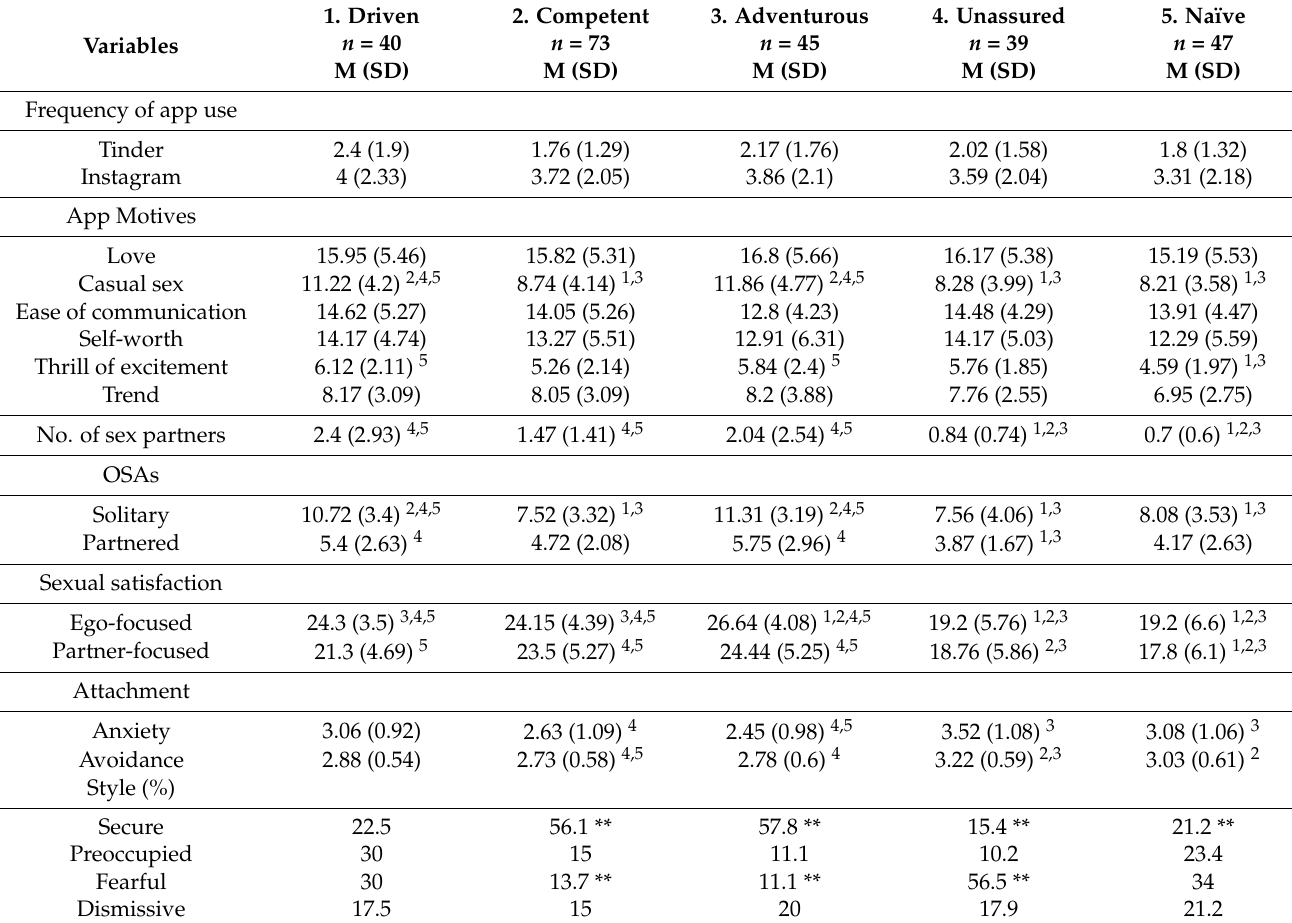
Table 2. Cluster